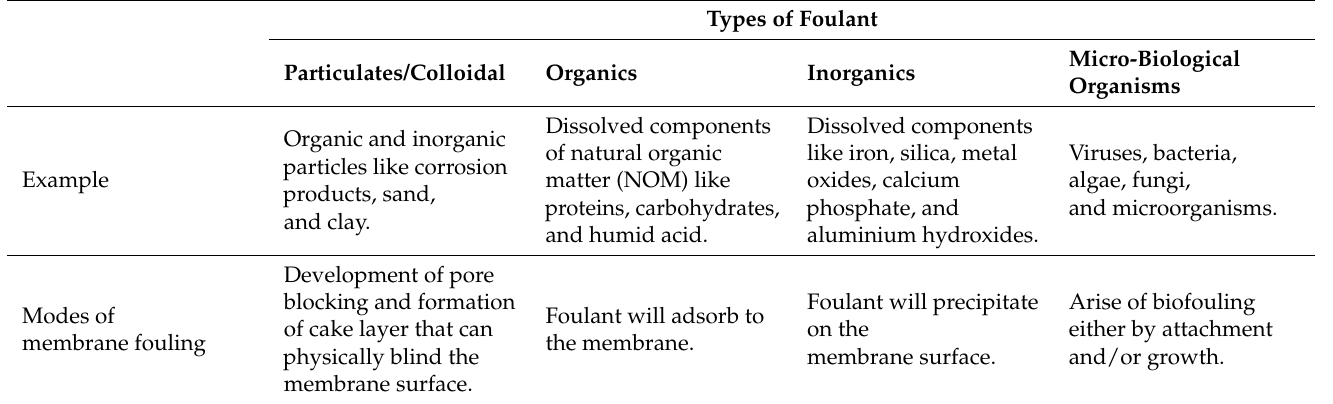
Table 2. Types of